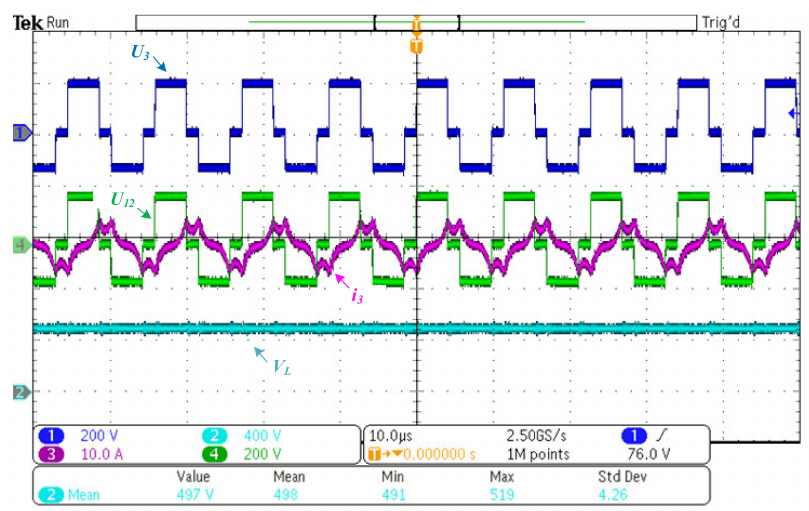
Figure 15. The key waveform before the switching point.